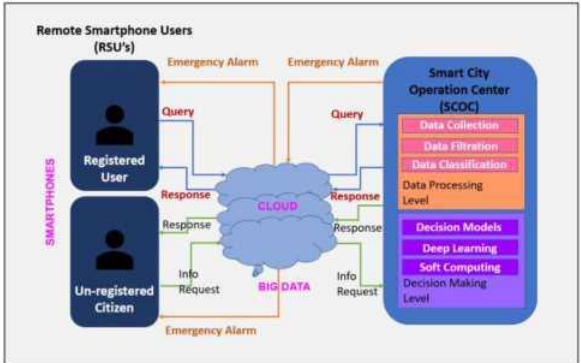
Figure 1 . Smart cities have three technological building-blocks: smartphones; big data; and the cloud SCOC is the brain of the system furnished with a heavy-duty system with parallel processing capabilities. All